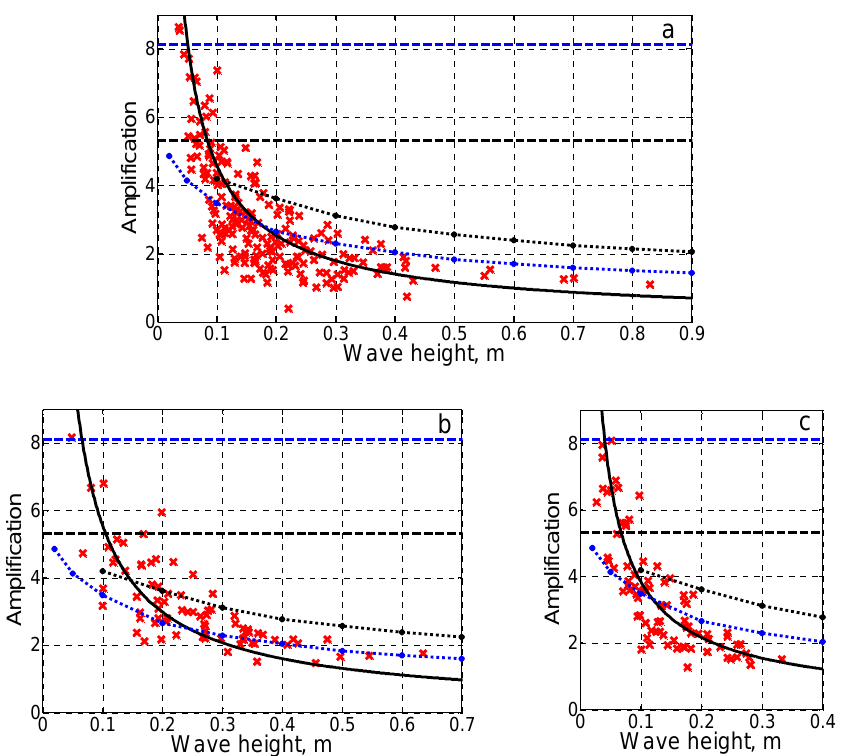
Fig. 11. Wave amplification on the beach plotted against wave height for wake waves from a) “SuperStar” (19 June 2009), b) “Star” (20 June 2009) and c) “Viking XPRS” (21 June 2009). Dashed lines correspond to Eq. (9) and dotted lines correspond to calculation of breaking run-up with the characteristic period of 6 (blue) and 14 (black) sec. Black solid line corresponds to the power approximation (10).